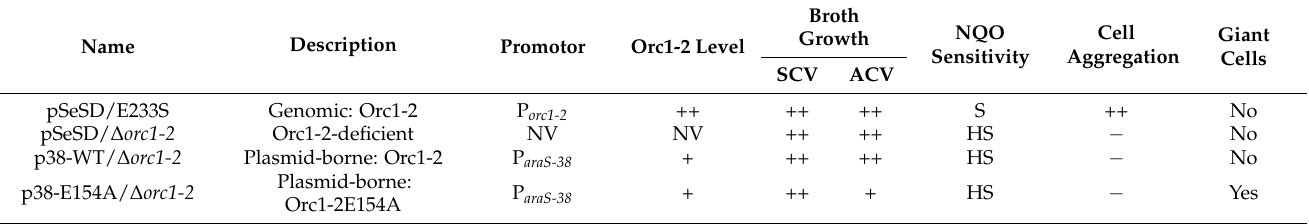
Table 2. Comparative study of S. islandicus Strains Expressing WT Orc1-2 and